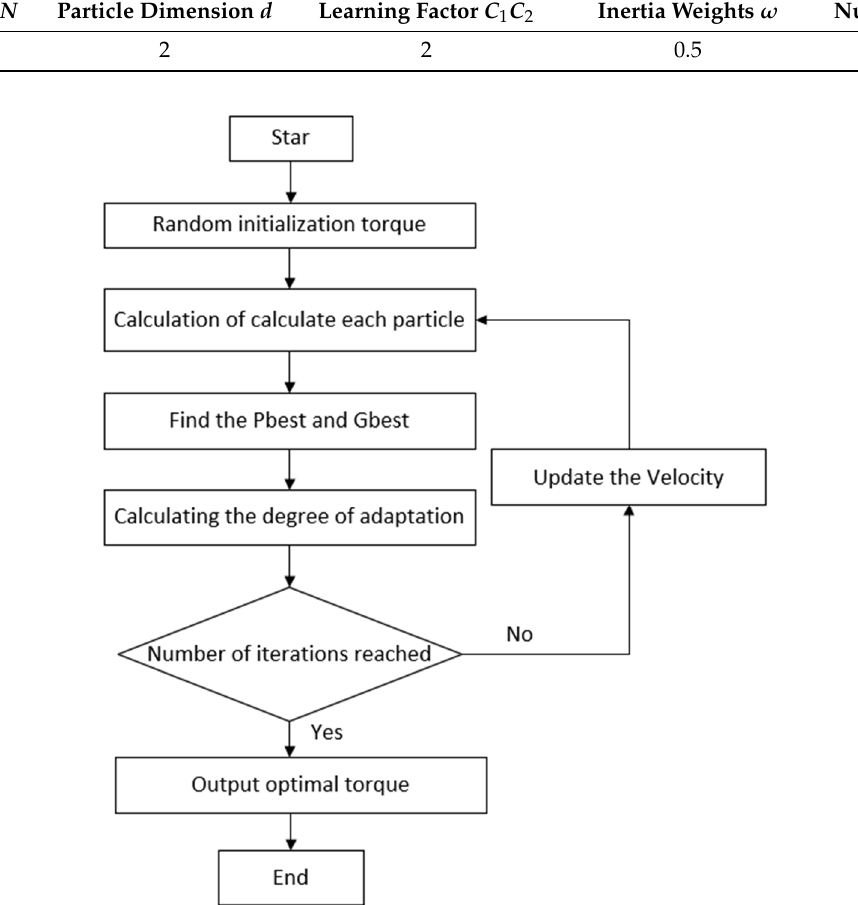
Figure 9. Algorithm flow chart. Table 1. PSO algorithm parameters.